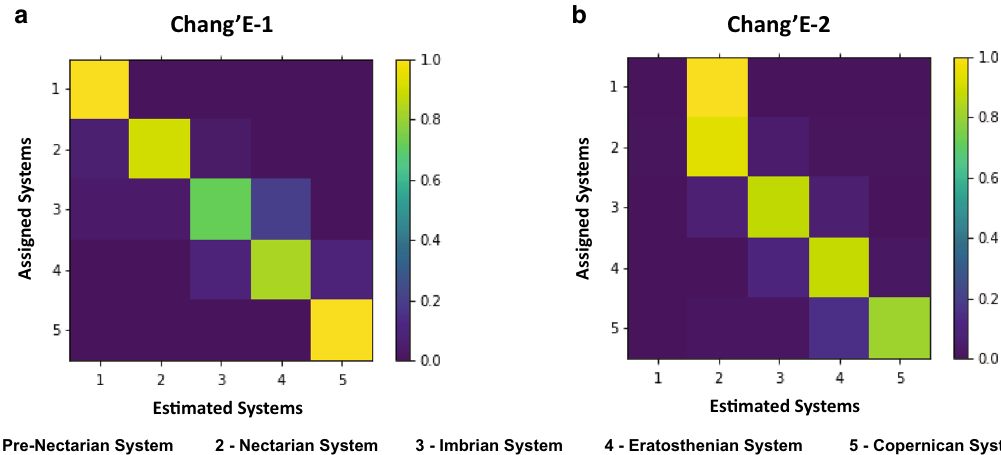
Fig. 6 Confusion matrix of the age estimation algorithm with Chang ’ E-1 (CE-1) data and Chang ’ E-2 (CE-2) data. Confusion matrices for the crater age classi fi cation task of CE-1 and CE-2 data reveal acceptable misclassi fi cation of different systems. Element ( i , j ) of each confusion matrix represents the probability of estimating system j given that the true system is i , with i and j referring to different systems. The diagonal of the matrix represents the probability of corrected classi fi cation for each system. Note that with both CE-1 and CE-2 images, there is some confusion between adjacent systems. For the fi rst stage of classi fi cation with CE-1 images, compared with other systems, the pre-Nectarian System and the Copernican System have a very high accuracy (100%). Some of the craters of the Imbrian System are confused with those of the Eratosthenian System. For the second stage with the CE-2 image, only two craters of the pre-Nectarian System are used for testing owing to the resolution and confusion with those of the Nectarian System. The diameters of craters in the Eratosthenian System and the Copernican System are relatively small, and craters of the Copernican System sometimes do not feature bright rays in the DOM data. However, the overall classi fi cation results are accurate and reliable for supporting scienti fi c analysis and interpretation. Source data are provided as a source data fi